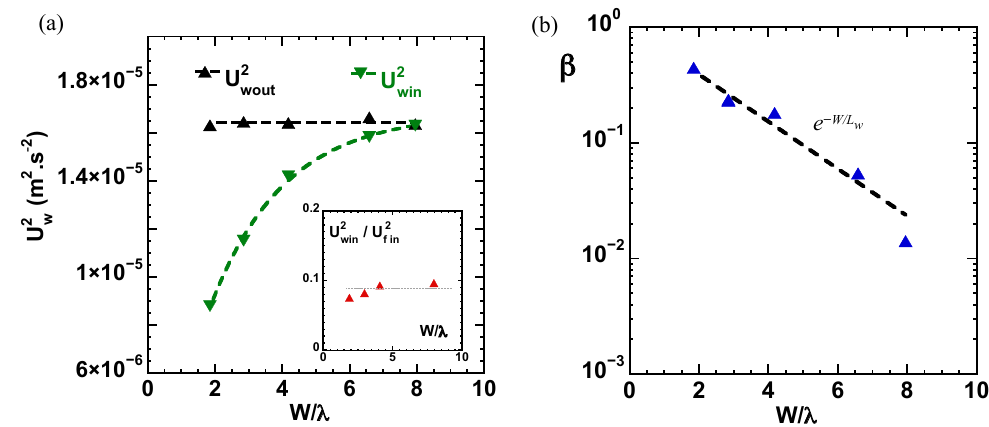
Figure 3. ( a ) Wave horizontal kinetic energies measured in the unbounded ( U 2 ( U 2 ) domains versus W / λ at a fixed vertical acceleration a = 1 g. Inset: Ratio of the wave horizontal win kinetic energy U 2 over the flow kinetic energy U 2 win for the wave motion β = ( U 2 wy − U 2 wx ) / U 2 w versus W / λ .